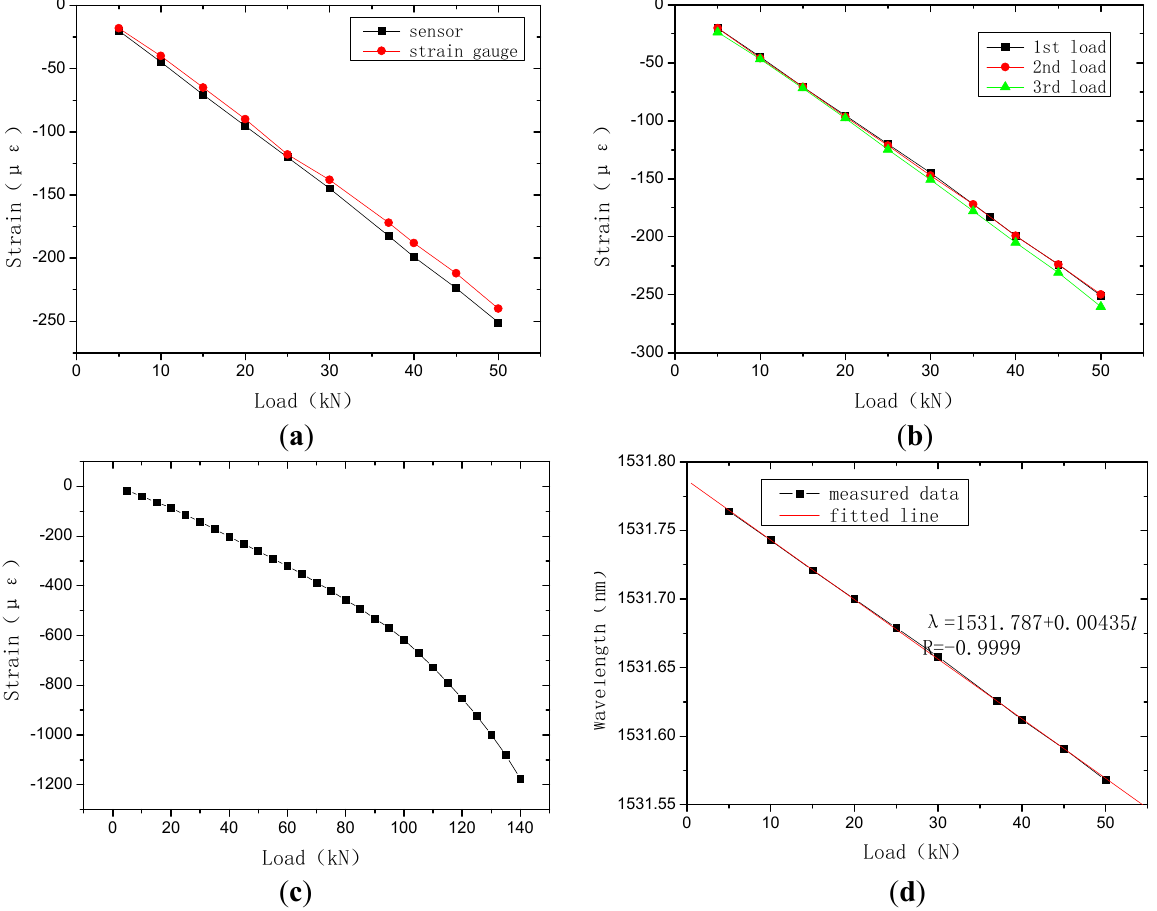
Figure 14. Compressive test results of concrete column: ( a ) Comparison of the developed sensor and resistance gauge; ( b ) Load-strain curve of three load-unload cycle; ( c ) Load-strain curve to failure; ( d ) Wavelength-load curve of the developed